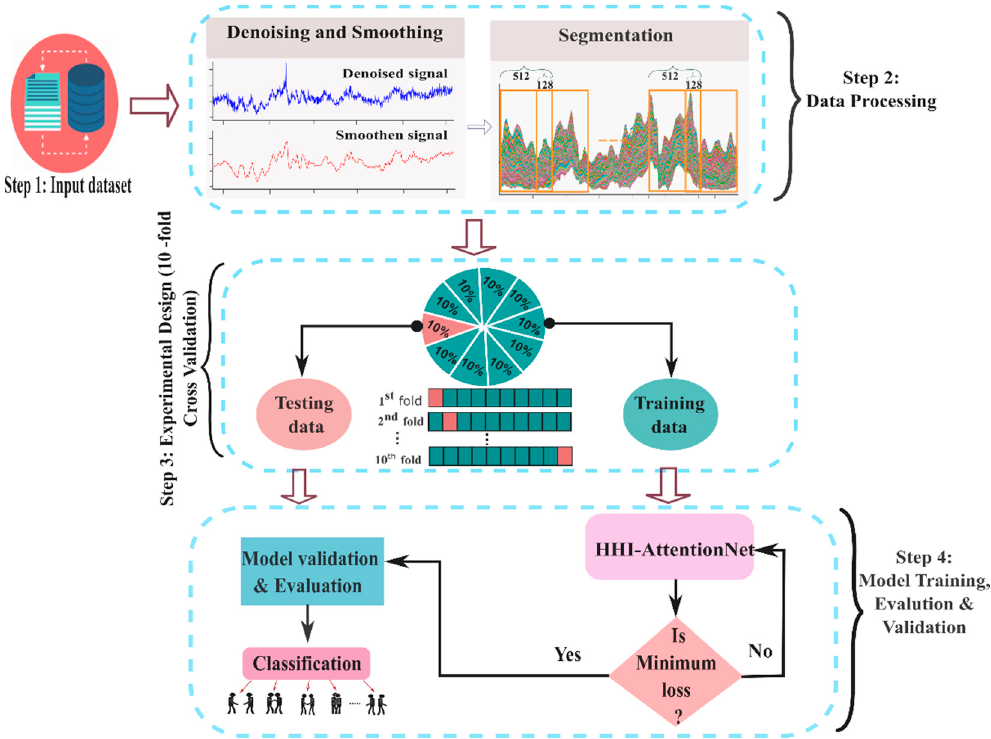
Figure 1. Block diagram of methodological steps to recognize HHI.